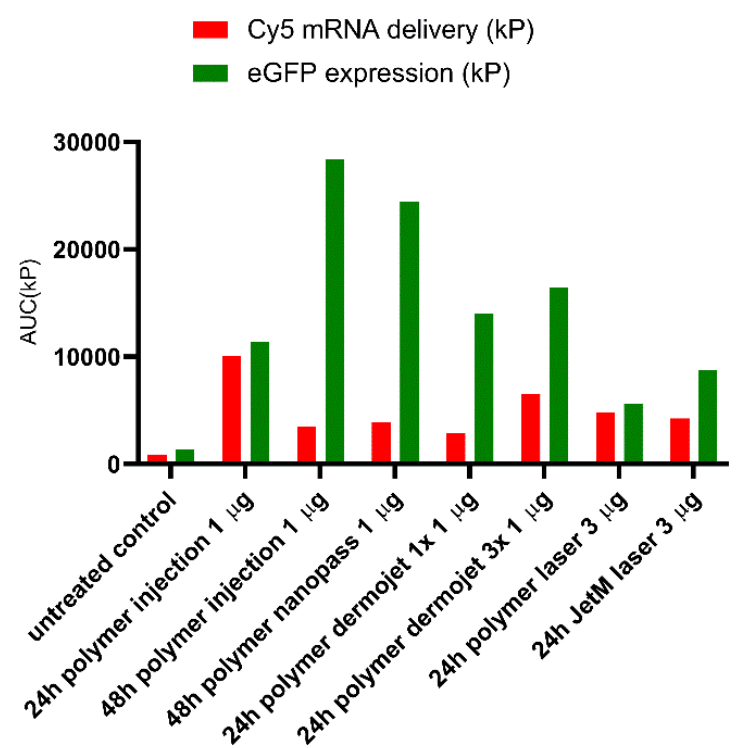
Figure 8. Delivery of Cy5 labeled mRNA and expression of eGFP as assessed by the AUC of pixel count-depth profiles. Cy5 labeled mRNA (red) and eGFP (green) area under the curve (AUC; based on the total pixel count vs depth profile) for the different delivery modalities. Striking and contrasting temporal effects were evident upon increasing the duration of incubation from 24 h to 48 h following ID injection of Cy5 labeled mRNA and eGFP expressing mRNA: longer incubation period clearly favored eGFP expression but facilitated elimination of Cy5 labeled mRNA. Use of the Dermojet ® 1-head device and Dermojet ® 3-head device resulted in similar eGFP expression, although the Cy5labeled mRNA appeared to be delivered more efficiently with the Dermojet ® 3-head device.